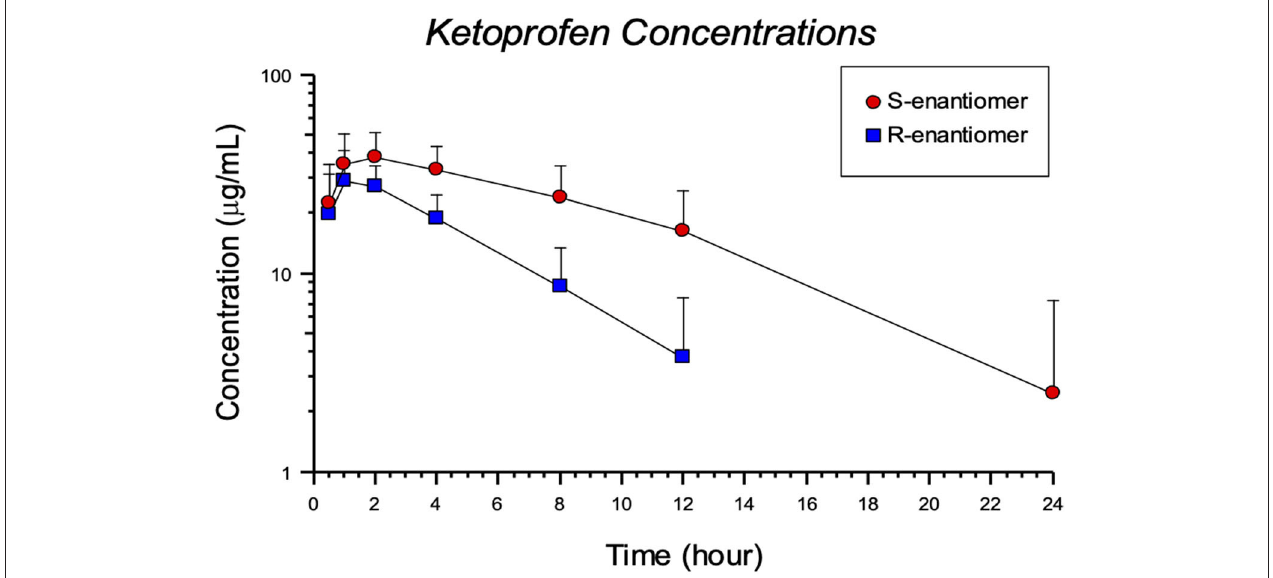
FIGURE 2 | Pharmacokinetic for S and R enantiomers after an 8 mg/kg ketoprofen intramuscular (IM) injection in Nile tilapia (Oreochromis niloticus) .